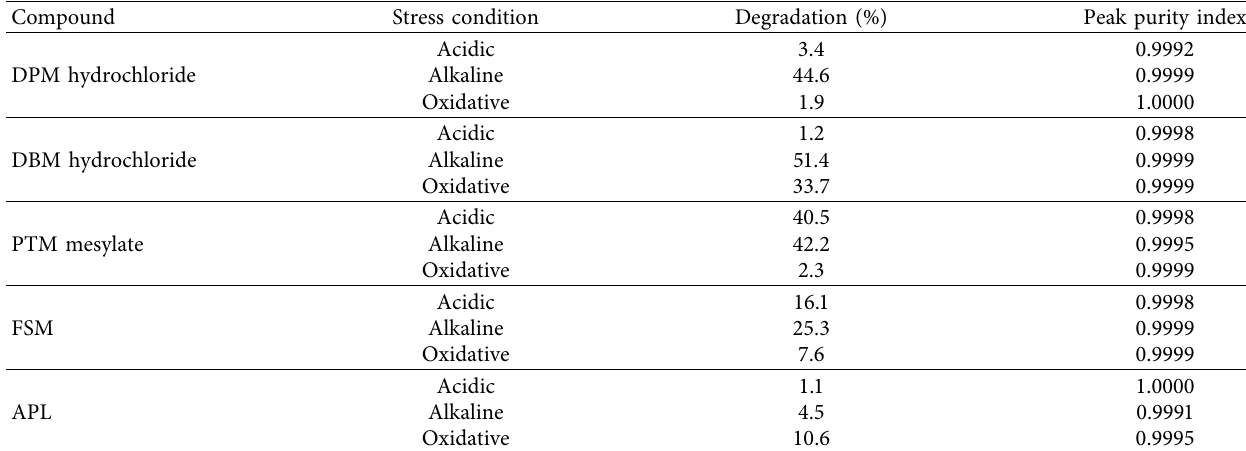
Table 3: Summary of the forced degradation of DPM, DBM, PTM, FSM, and APL.